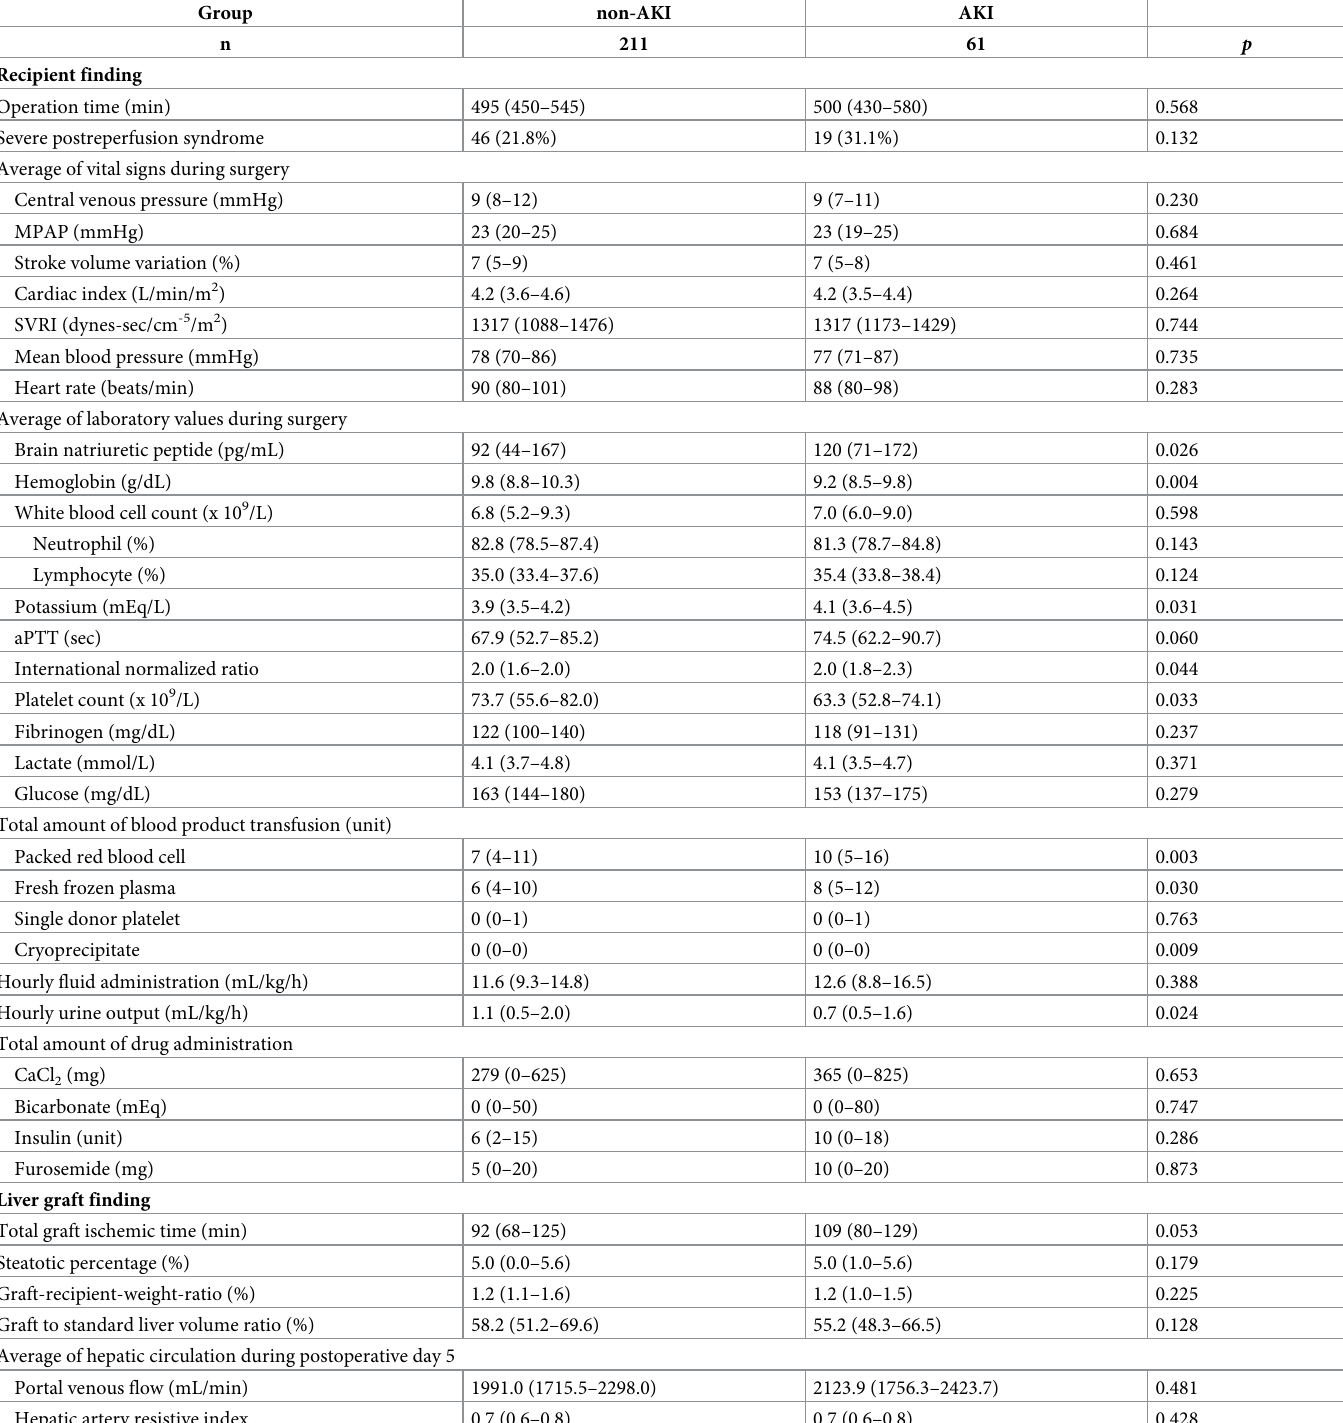
Table 2. Comparisons of intraoperative recipient and graft findings between non-AKI and AKI groups in patients undergoing living donor liver